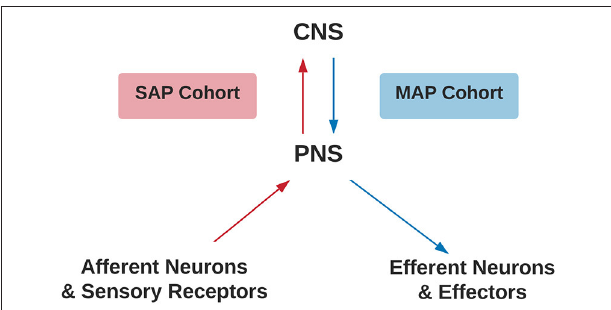
FIGURE 1 | Criteria for SAP and MAP cohorts. Assignment of SAP (red) or MAP (blue) cohorts differentiated by disruption to afferent or efferent CNS processing, respectively. CNS, Central Nervous System; PNS, Peripheral Nervous System; SAP, Sensory Altered Processing; MAP, Motor Altered